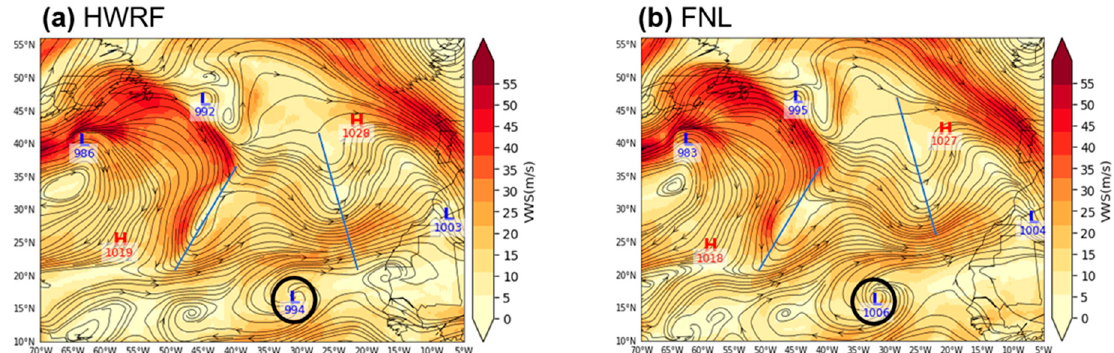
Figure 4. Deep-layer (200–850 hPa) vertical wind shear (VWS, shaded), 200 hPa streamlines, and mean sea level pressure (MSLP) centers in the environment near Hurricane Irma (2017) from ( a ) 12 h into an HWRF forecast initialized at 1200 UTC on 30 August 2017 and ( b ) Final Analysis (FNL) valid at 0000 UTC on 31 August 2017. The center position of Irma is identified by a black circle. VWS has units of m s − 1 , and MSLP has units of hPa. The trough axes relevant to these discussions are marked by blue lines.